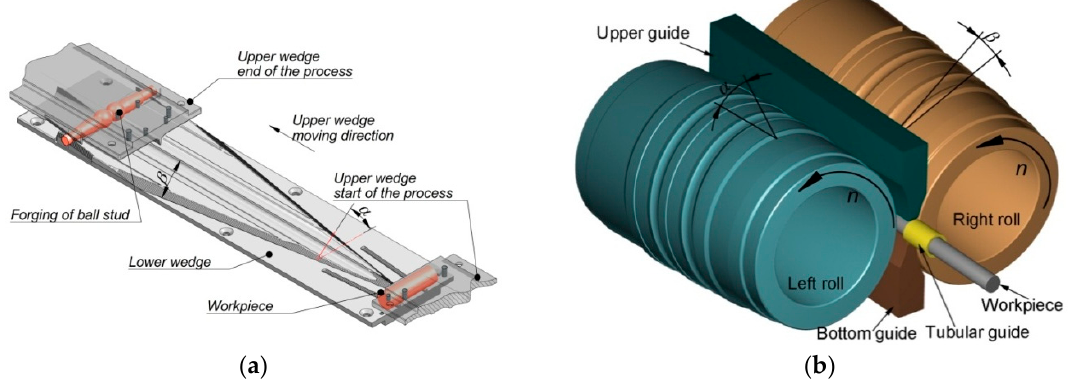
Table 1. Percentage of chemical elements for C45 steel determined by emission spectrometry.